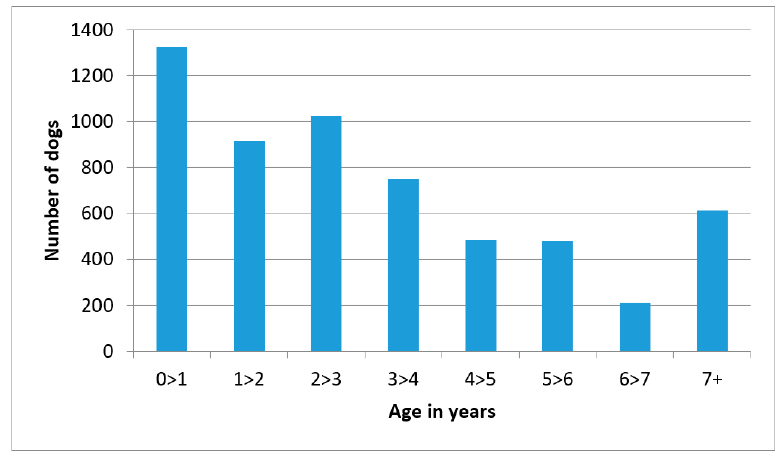
Figure 2. Ages of owned dogs.